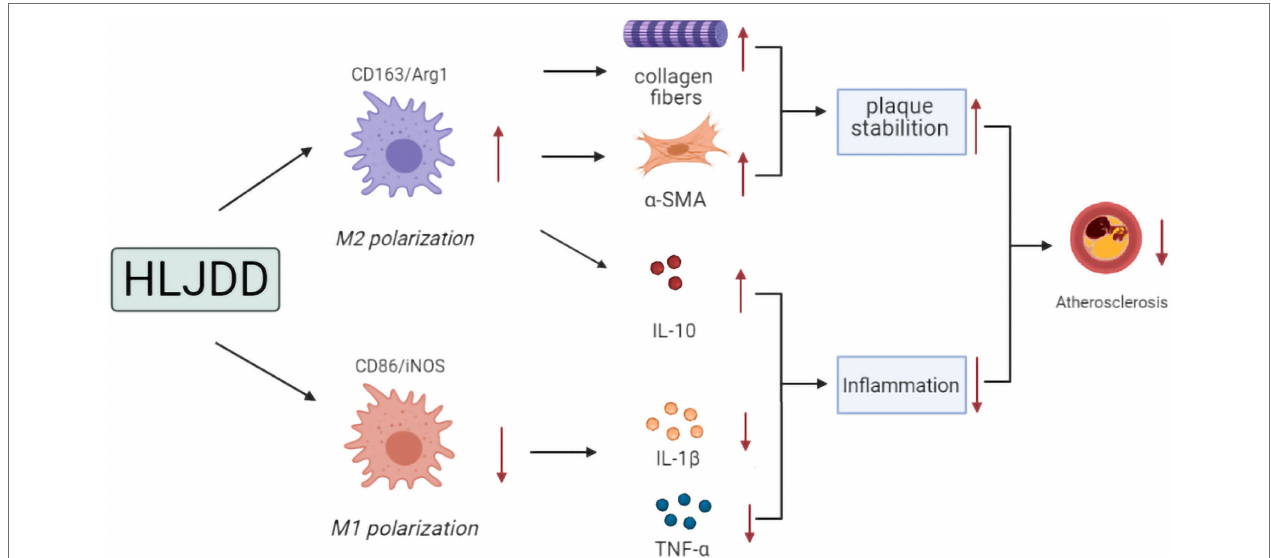
FIGURE 6 | Possible mechanism pathway of the anti-atherosclerotic effect of